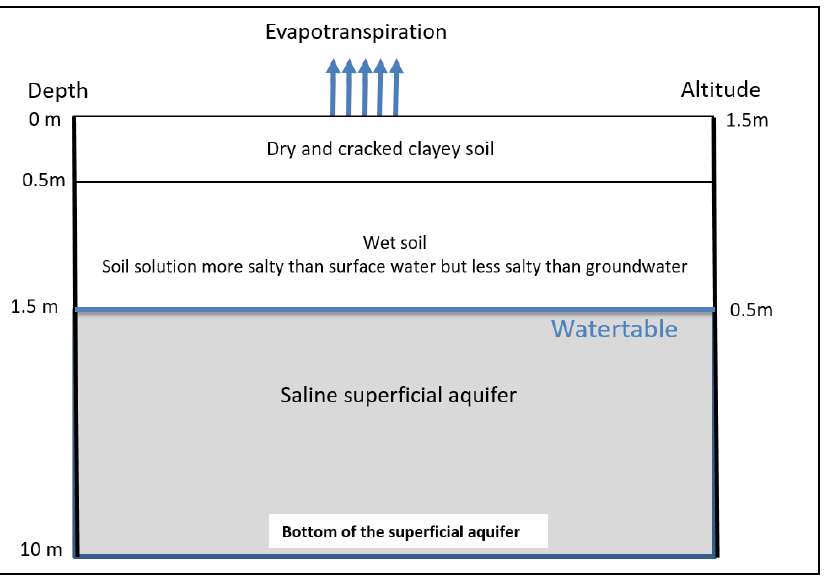
Figure 8. Conceptual diagram of the water and saline functioning of the soil–aquifer system in the irrigated plots of the DFS in dry periods.